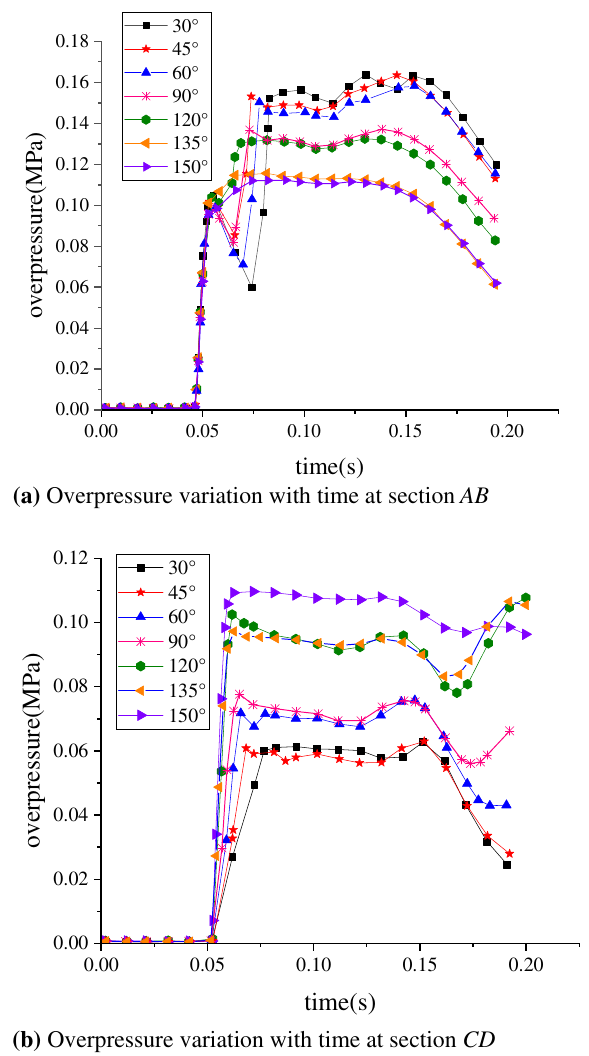
Fig. 7 Gas overpressure variation with time at different cross sections and for different bend angles